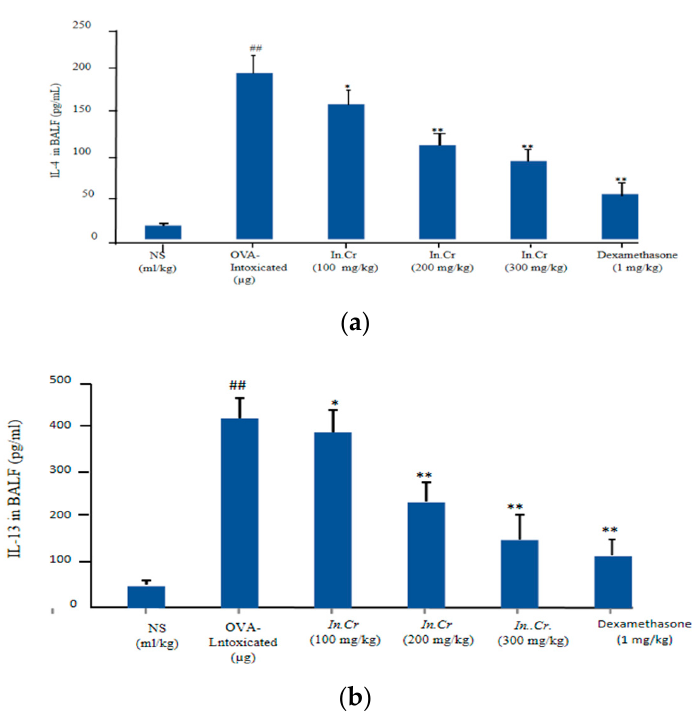
Figure 5. ( a ) and 4( b ). In.Cr significantly decreased the levels of Interleukins (IL-4 and IL-13) in the BALF compared to OVA-treated mice. The ovalbumin (OVA)-treated mice unveiled rises in cytokines i.e., IL-4 as well as IL-13 compared to the controls. ## p < 0.05 and ** p < 0.05 are more significant while * p < 0.01 is significant ( n =